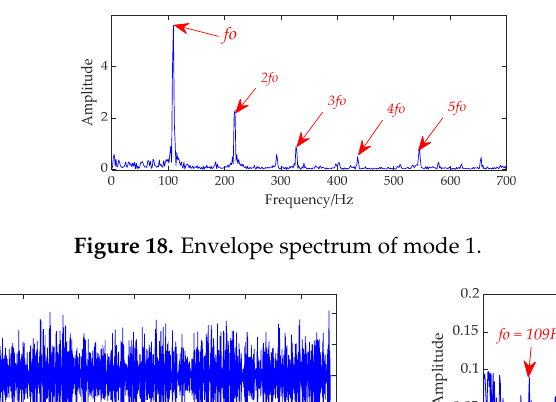
using CLNGO-MNAD. ( b ) Envelope spectrum